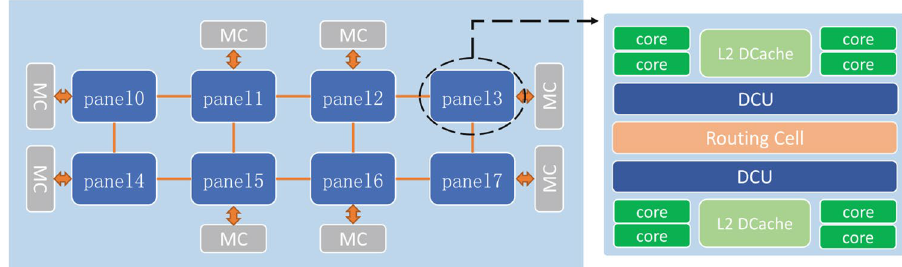
Figure 2. FT2000+ processor architecture.